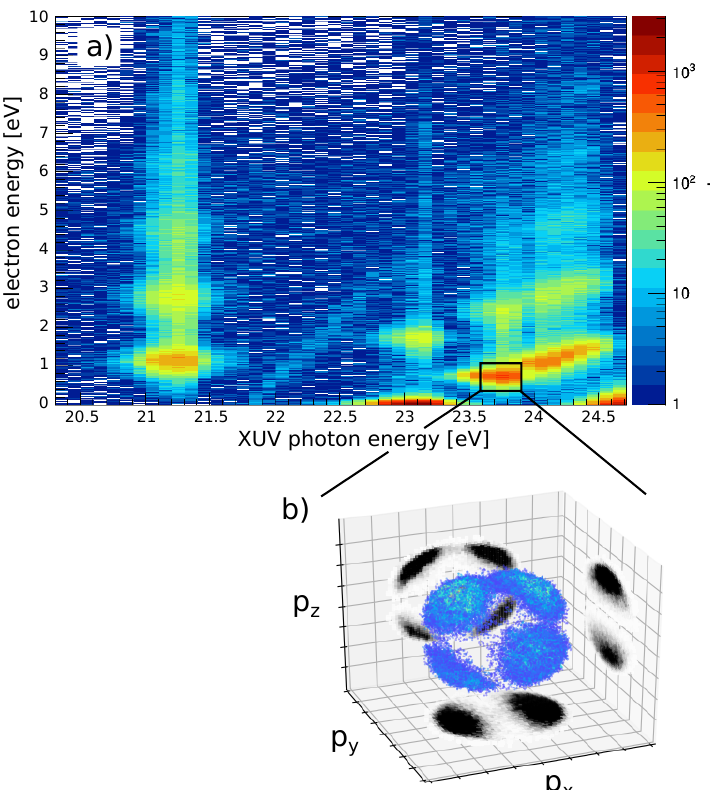
Figure 3. ( a ) XUV photon energy scan with delayed IR-laser pulse, plotted versus photoelectron kinetic energy. Resonances in helium are revealed for specific XUV energies and above threshold ionization (ATI) can be seen by the distribution of the photoelectron kinetic energy. ( b ) Electron momentum distribution at the specific region indicated by the black square. The XUV is polarized along p x , the IR along p z